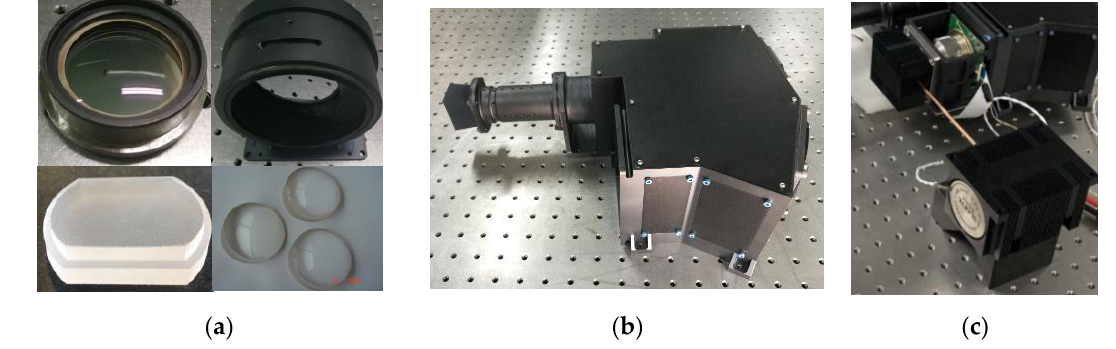
Figure 6. Spectrometer prototype: ( a ) Optical and mechanical elements; ( b ) prototype; ( c ) detector.